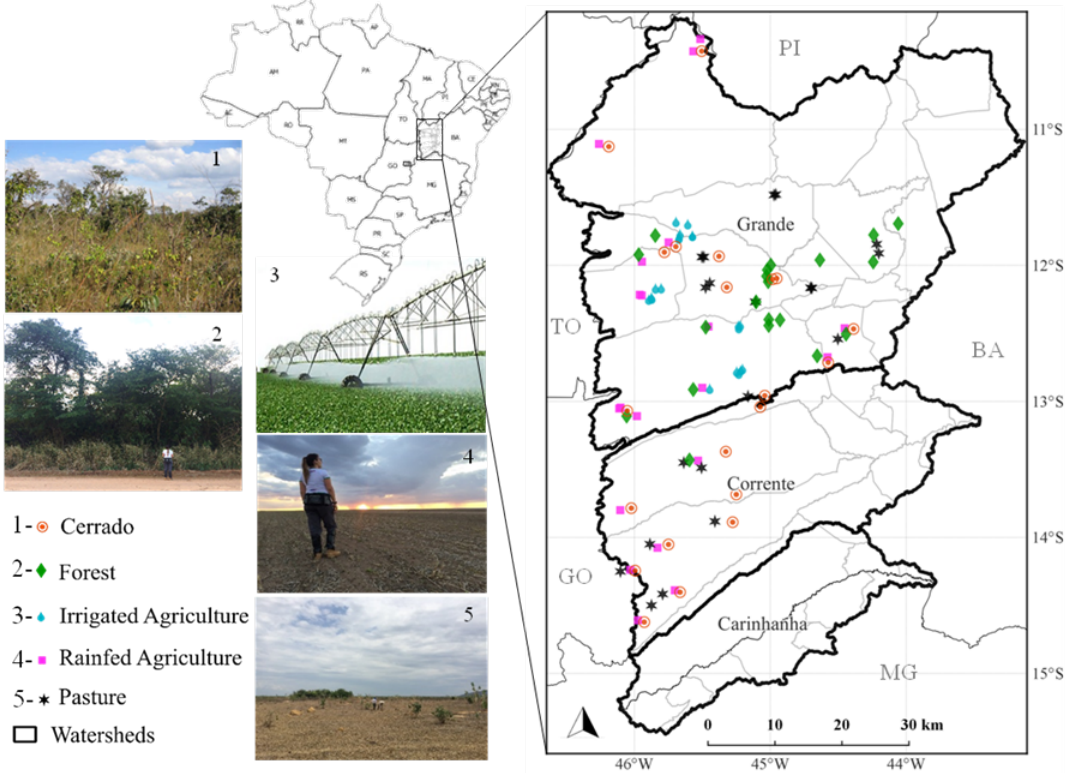
Figure 1. Study area and location of the soil samples collected considering different land use and land cover in Western